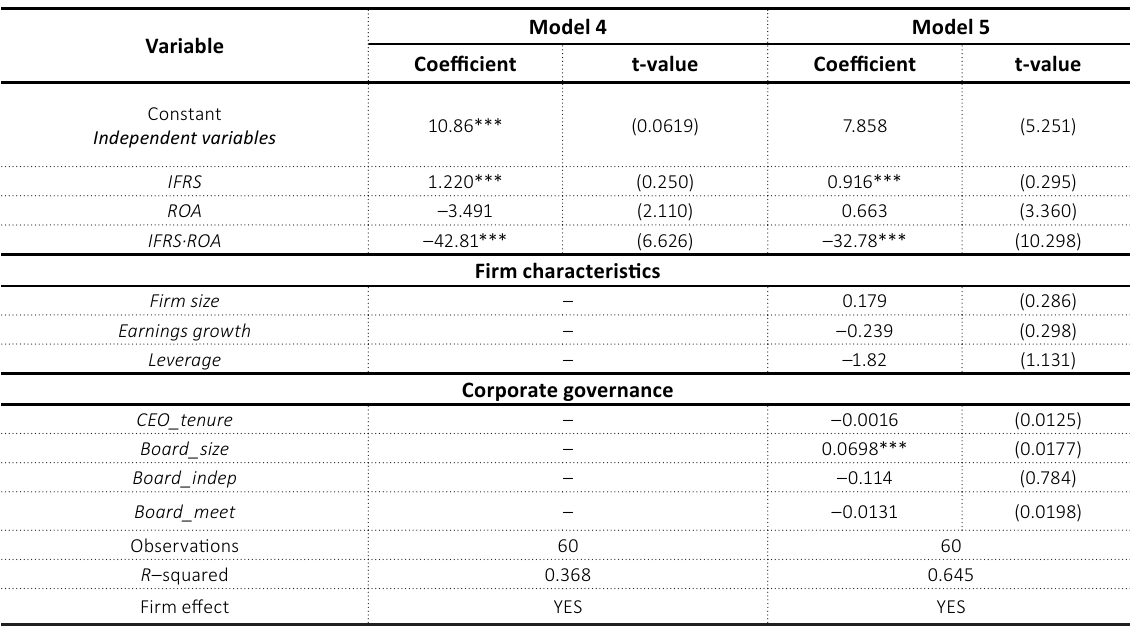
Source: Authors’ survey